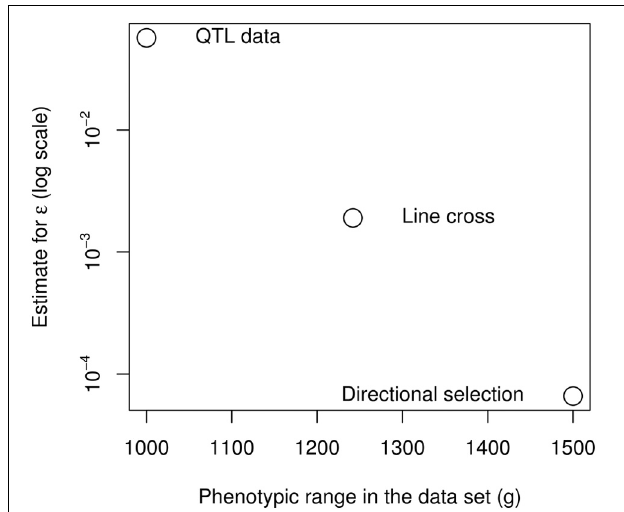
FIGURE 7 | Negative relationship between the span of the phenotypes in the data set and the directional epistasis coefficient.